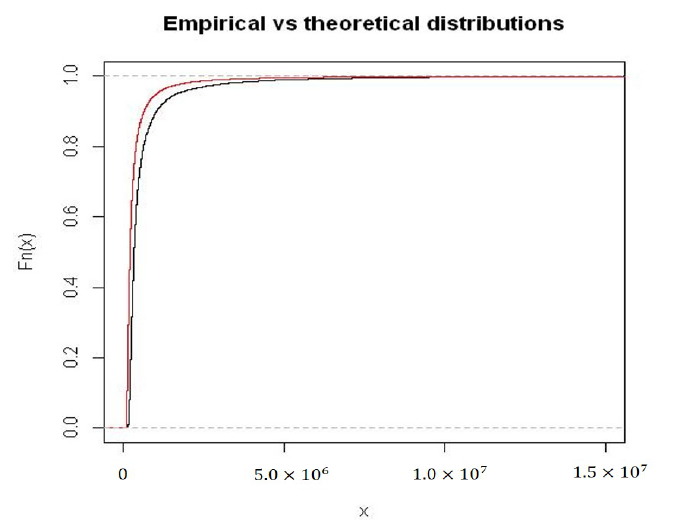
Figure 4. Lognormal–Burr and empirical distribution functions (red and dark lines). Table 6. Estimated parameters and 99% confidence intervals of Lognormal–GPD.